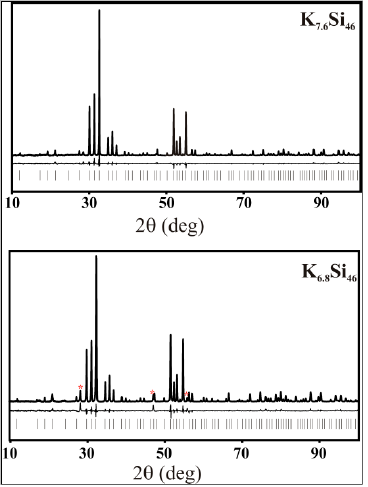
Figure 3. Powder X-ray diffraction (PXRD) patterns of the SPS-prepared clathrates-I K 7.6 Si 46 (550 °C) and K 6.8 Si 46 (600 °C). Red asterisks mark the reflections of α -Si (<0.2 mass % in K 7.6 Si 46 and 1.5 mass %